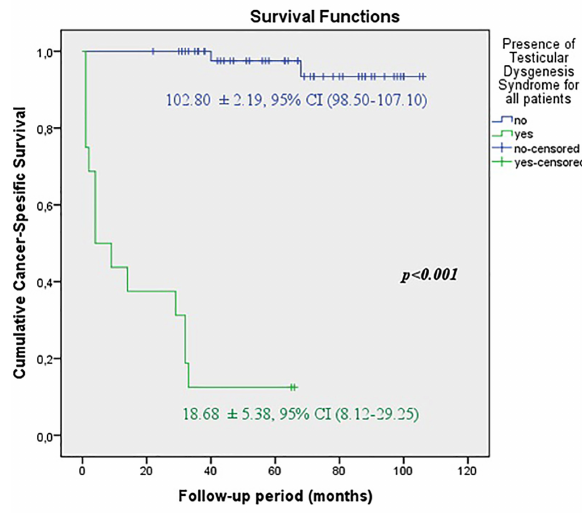
Figure 2A - Kaplan-Meier plots of recurrence-free survival according to presence of Testicular Dysgenesis Syndrome for all patients.